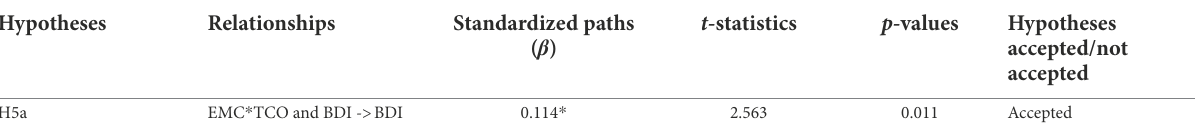
FIGURE 4 Moderating effect (EMC*TCO and BDI).